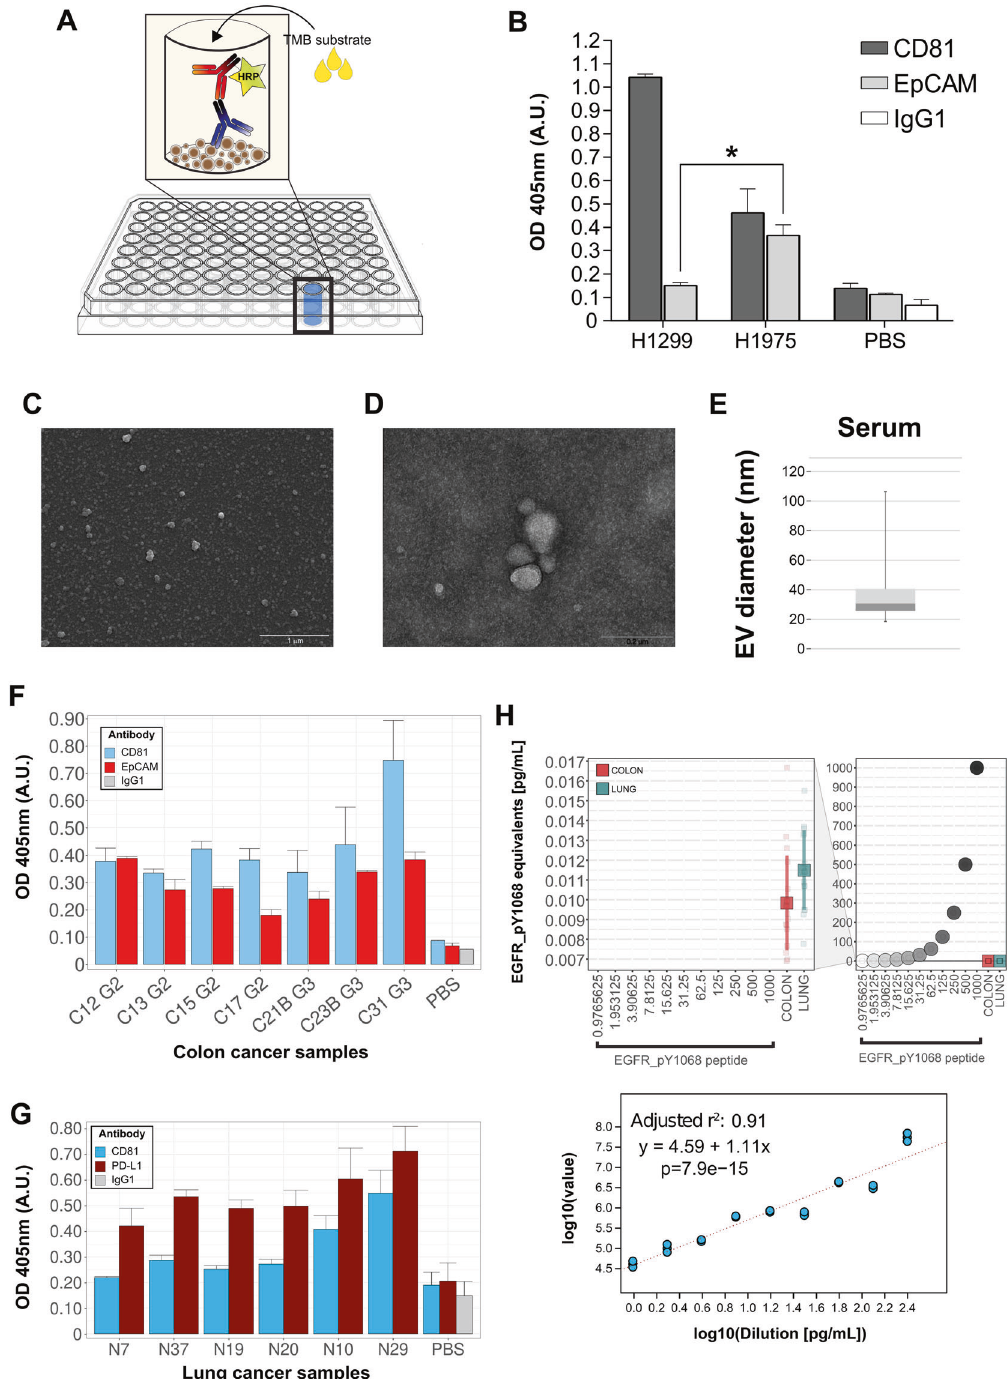
Fig. 2 Orthogonal validation of RPPA results on serum-derived EVs. A Representative scheme of our homemade ELISA test, i.e. ELEXO, including EV-coated microtiter plate, primary antibody, HRP-conjugated secondary antibody and colorimetric reaction with TMB substrate. B H1975 and H1299 EVs analyzed by ELEXO assay. IgG isotype and Phosphate-Buffered Saline (PBS) were used as internal controls. Data are reported as mean and SD ( n = 3) of arbitrary units of O.D. (Optical Density) at the speci fi ed wavelength (nm) (* p = 0.02). C , D Representative images of SEM ( C ) and TEM ( D ) analysis of EVs isolated from the sera of prostate cancer patients. Images are representative of pivotal and training cohort PCas. E Box plot representative of serum EV size distribution evaluated by SEM analysis. F , G ELEXO measurement of EpCAM ( F ) and PD-L1 ( G ) antigens in EVs isolated from colon and lung cancer patients, respectively. CD81 has been used as endogenous EV control. Data are reported as mean and SD ( n = 3) of arbitrary units of O.D. (Optical Density) at the speci fi ed wavelength (nm). Internal reference controls were reported as IgG, CD-81, EpCAM, or PD-L1 antibody in PBS condition. H Absolute RPPA quanti fi cation of EGFR_pY1068 synthetic peptide in dilution curve along with isolated EVs from sera of colon and lung cancer patients. The expression levels in EVs fall below the lowest EGFR_pY1068 peptide dilution point and their scale is magni fi ed in the left panel of the plot. The reference curve in the lower panel was obtained as in Fig. 1D to predict absolute EGFR_pY1068 RPPA levels in EV